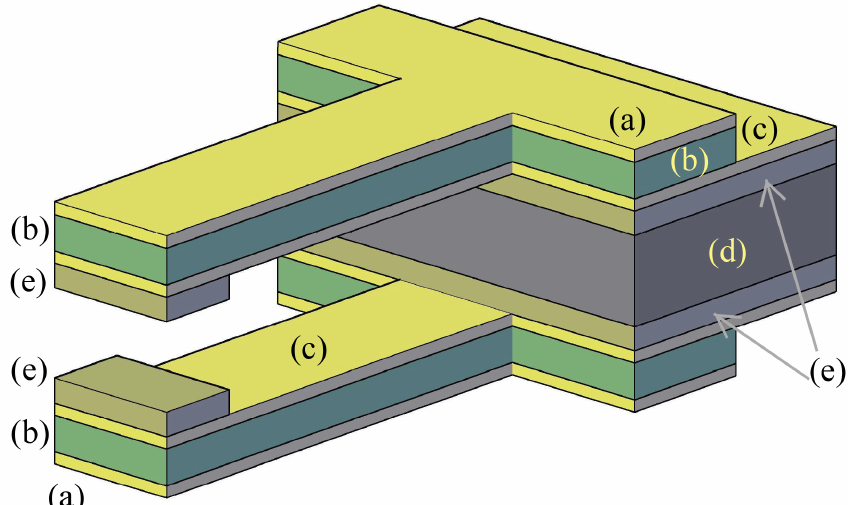
Figure 2. An alternative layout for the microgripper: outer layers with a same voltage V 0 ( a ); structural material for the beams ( b ); internal layers with voltage V i ( c ) and structural layer for the handle ( d ).